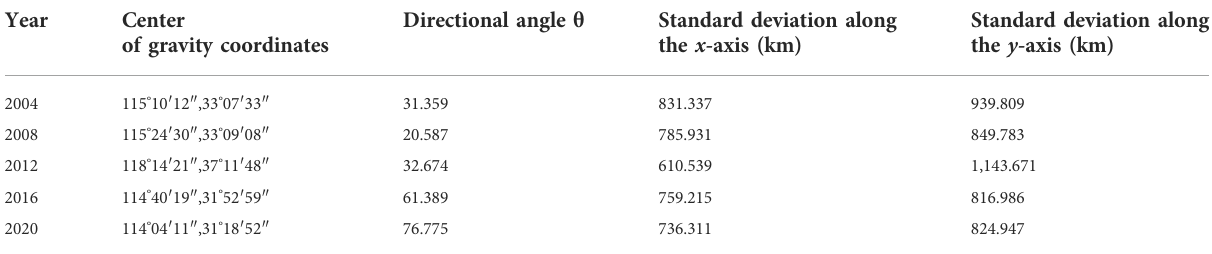
TABLE 4 Statistical description of standard deviation results.